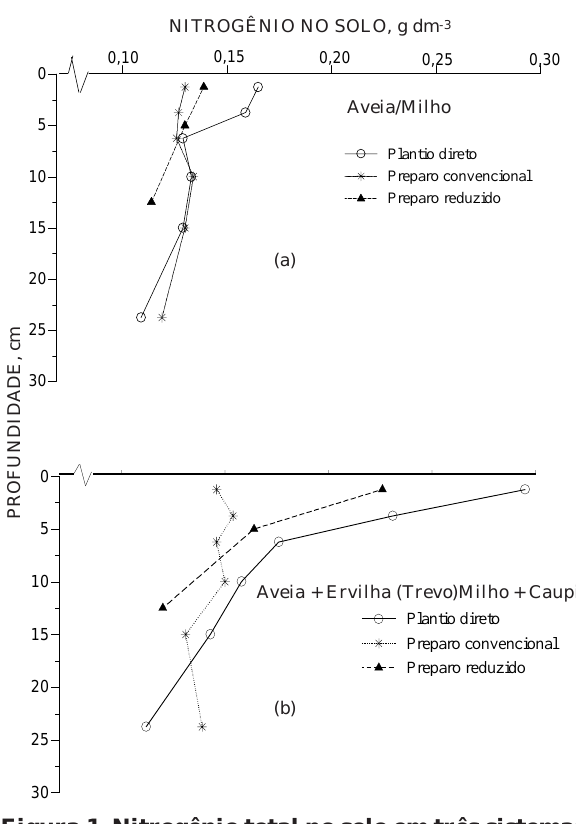
Figura 1. Nitrogênio total no solo em três sistemas de preparo aveia/milho (a) e aveia + ervilhaca/ milho + caupi (b) utilizados durante nove anos em parcelas sem adubação nitrogenada mineral